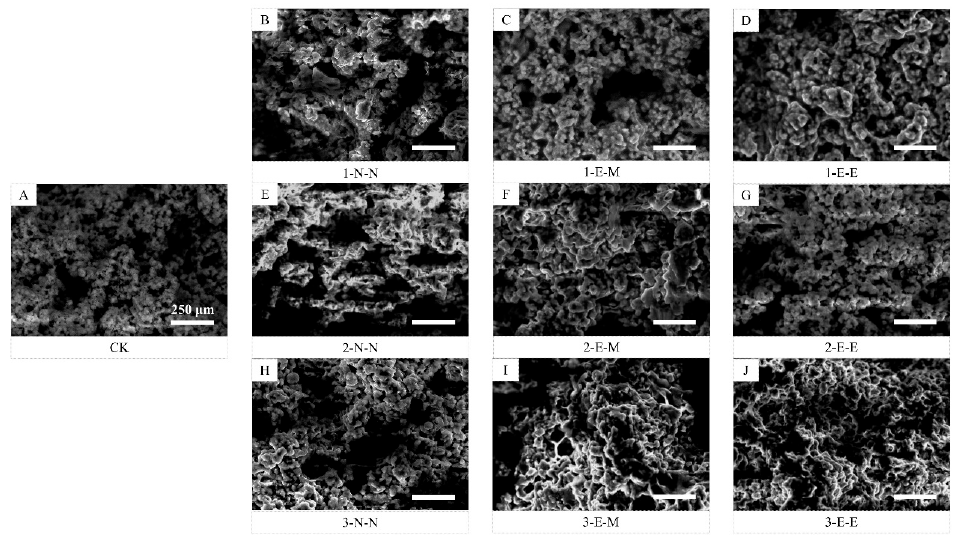
Figure 3. SEM images of freeze–thawed Mongolian